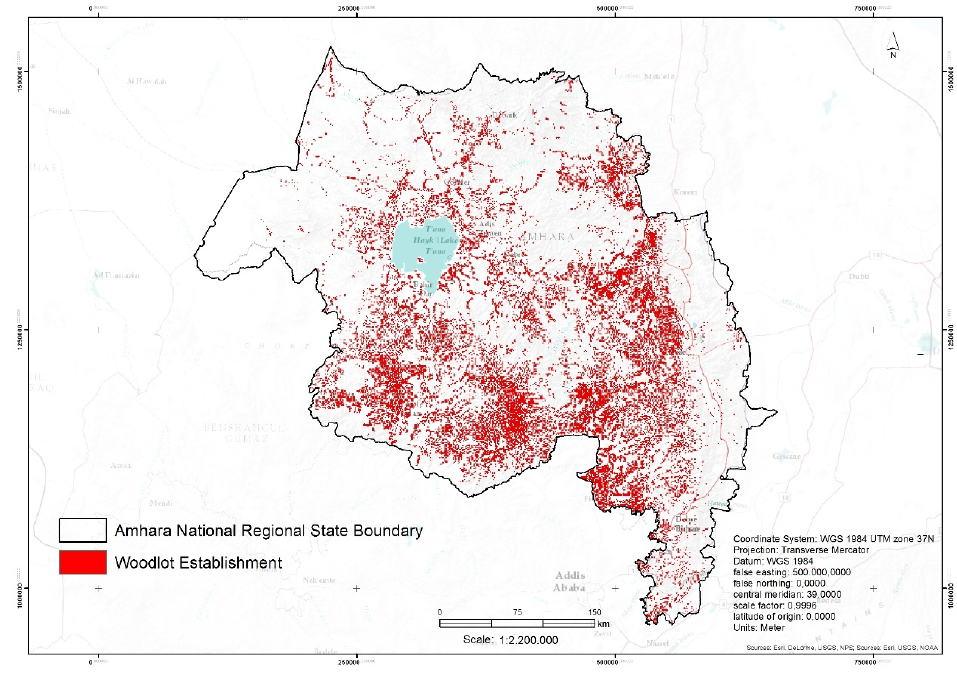
Figure 7. Opportunity areas for mixed species woodlot establishment.